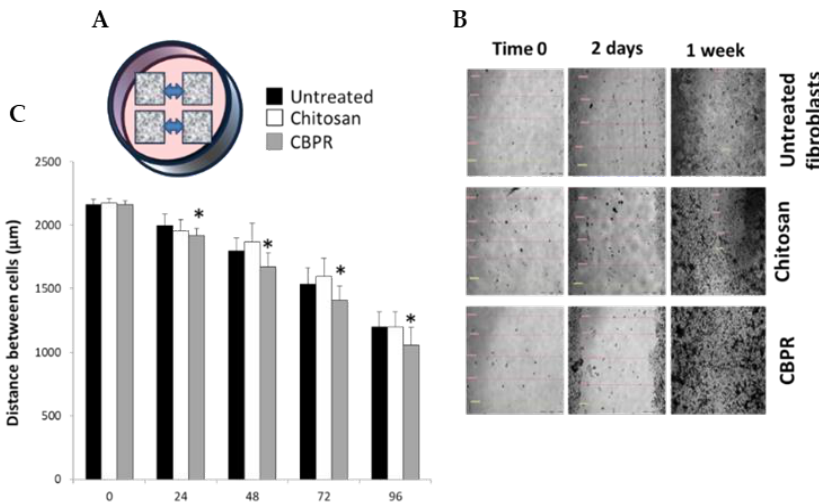
Figure 7. Regenerative effect of chitosan films on human dermal fibroblasts. The regenerative activity assay was performed in Micro-Insert 4-well dishes ( A ), the distances between the frames was monitored under the microscope (20 × magnification) for 7 days and photos were taken ( B ). The distances between the frames were recorded and the results are expressed as mean ± SD of the measurements by microscope (n = 6) carried out in two individual experiments ( C ). the statistical analysis was performed with a two-tailed Student’s t -test. * p ≤ 0.05 (chitosan- and CBPRfilm-treated cells vs. untreated cells).